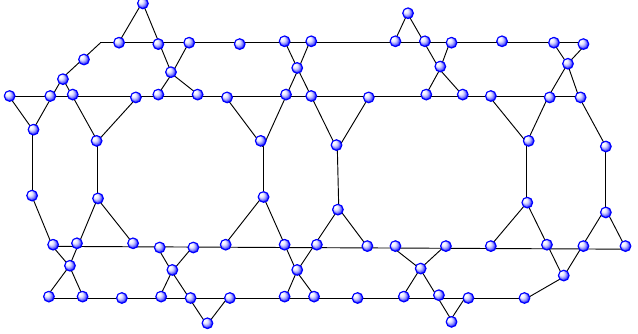
Figure 4. Line graph of H 3 BO 3